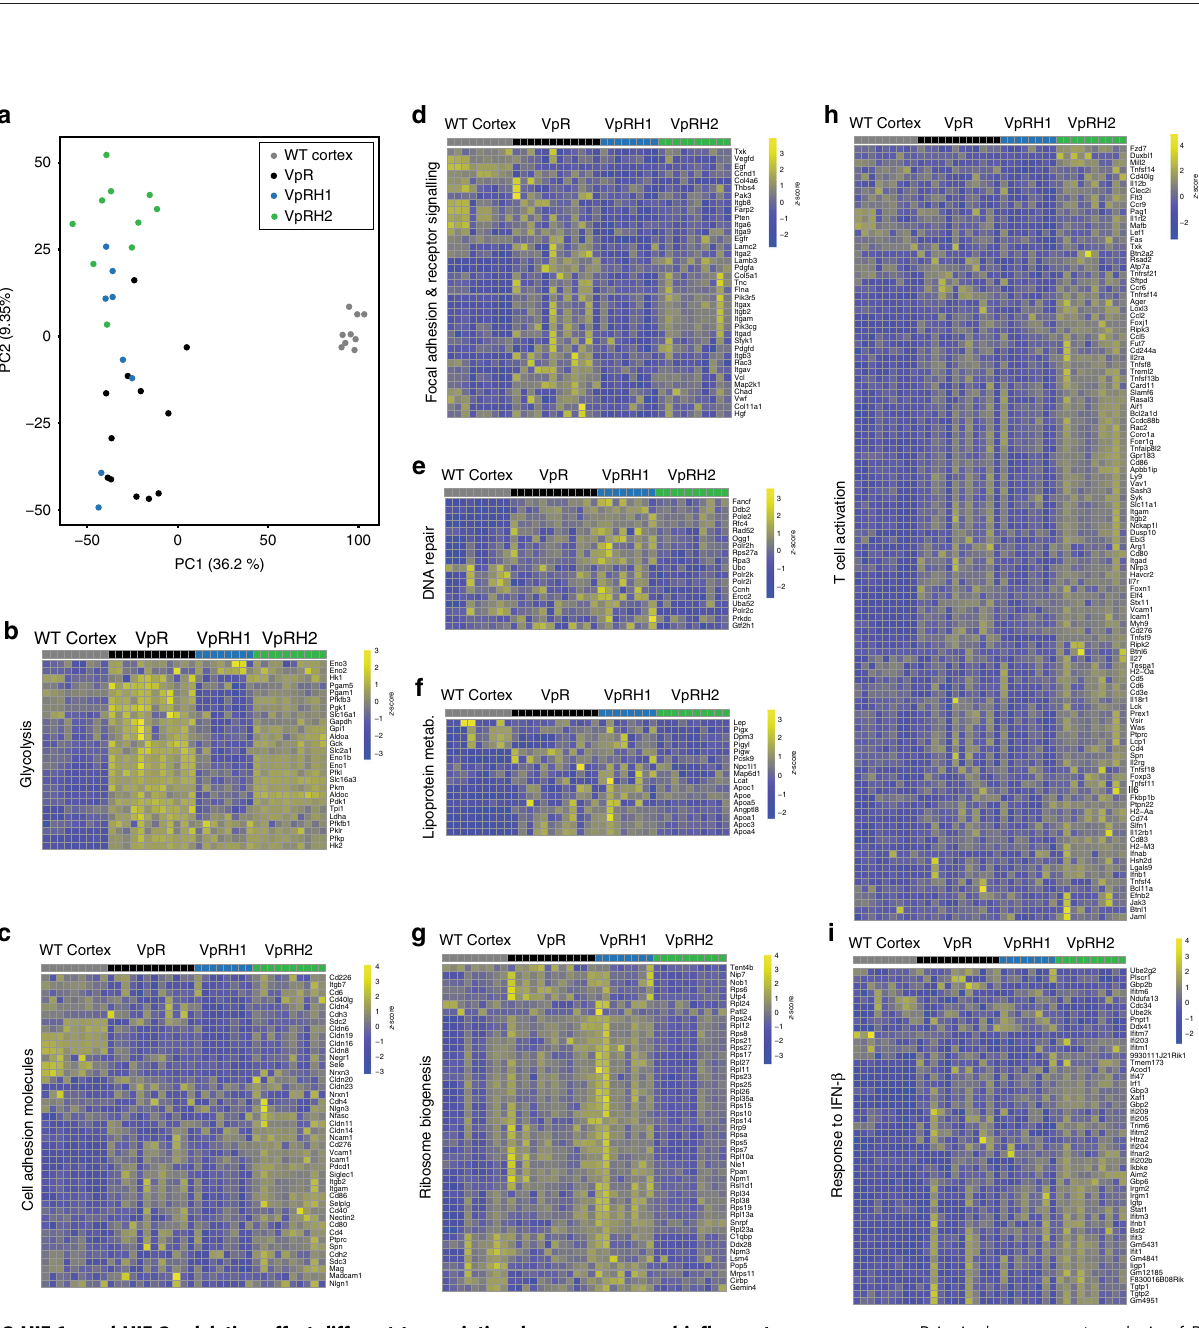
Fig. 2 HIF-1 α is dispensable for cellular proliferation and for allograft tumour formation. a 3T3 proliferation assays of MEFs derived from mice of the indicated genotypes infected with adenoviruses expressing GFP or Cre. Mean± std. dev. are derived from three independent cultures. b 3T3 proliferation assays of MEFs derived from Vhl fl / fl Trp53 fl / fl mice infected with non-silencing shRNA (shRNA-ns) or shRNA against Hif1a (shRNA- Hif1a #1 and shRNA- Hif1a #2), followed by infection with adenoviruses expressing GFP or Cre. Mean ± std. dev. are derived from three independent cultures. c , d Proliferation assays of mouse ccRCC cell line 2020 expressing empty vector control or human pVHL30 c or non-silencing shRNA (shRNA-ns) or shRNA against Hif1a (shRNA- Hif1a #1 and shRNA- Hif1a #2) d . Mean ± std. dev. are derived from two independent experiments each with replicates of six cultures. e – g Representative images (scale bars depict 200 μ m) e and size distributions f , g of spheres formed by the cells described in c , d when grown in non-adherent cell culture plates. Mean± std. dev. of the total number of colonies pooled from three independent experiments are shown, P values were calculated by two-sided Student ’ s t test. h , i Survival of mice following subcutaneous allograft tumour assays of the cells described in c into SCID-Beige mice. P values were calculated by two-sided log-rank Mantel – Cox test.